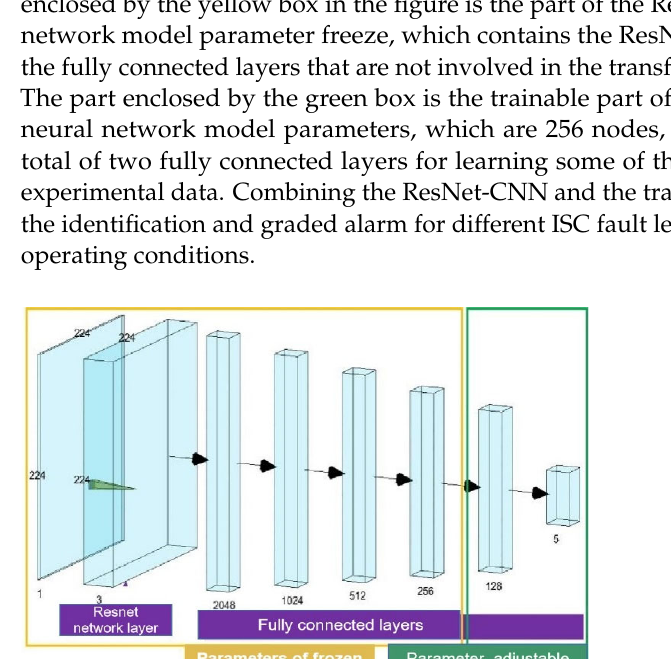
Table 3. Division of simulation data training and test sets.